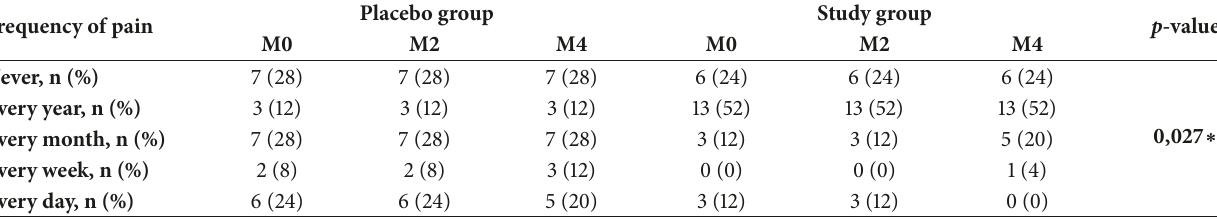
Table 3: Frequency of pain in patients with